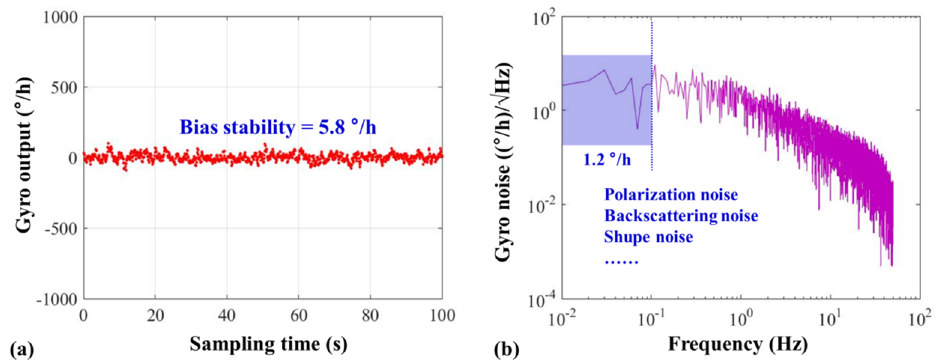
Figure 10. Test result of the HC-RFOG based on LNMFLs. ( a ) Data of the HC-RFOG with a sampling bandwidth of 10 Hz. ( b ) Spectral distribution of the noise of the HC-RFOG.